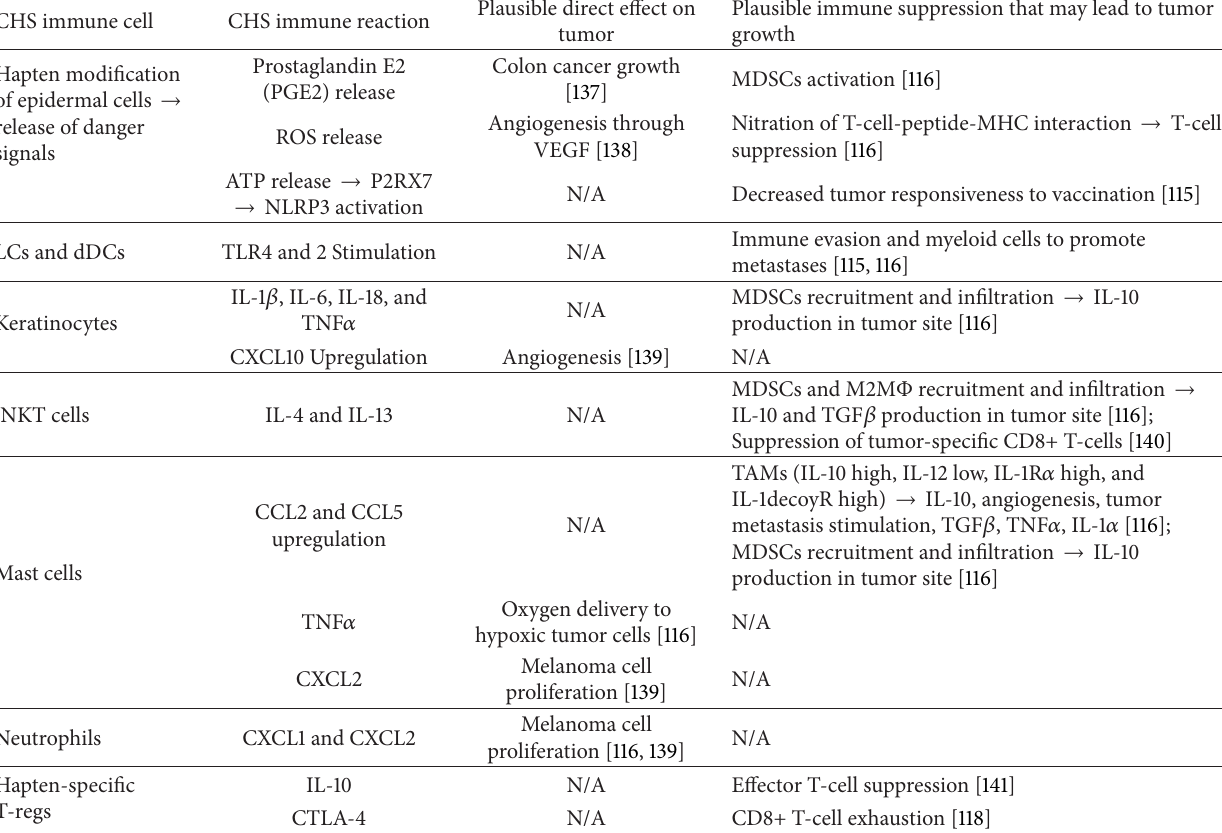
Table 3: Contact hypersensitivity reactions that may lead to tumor